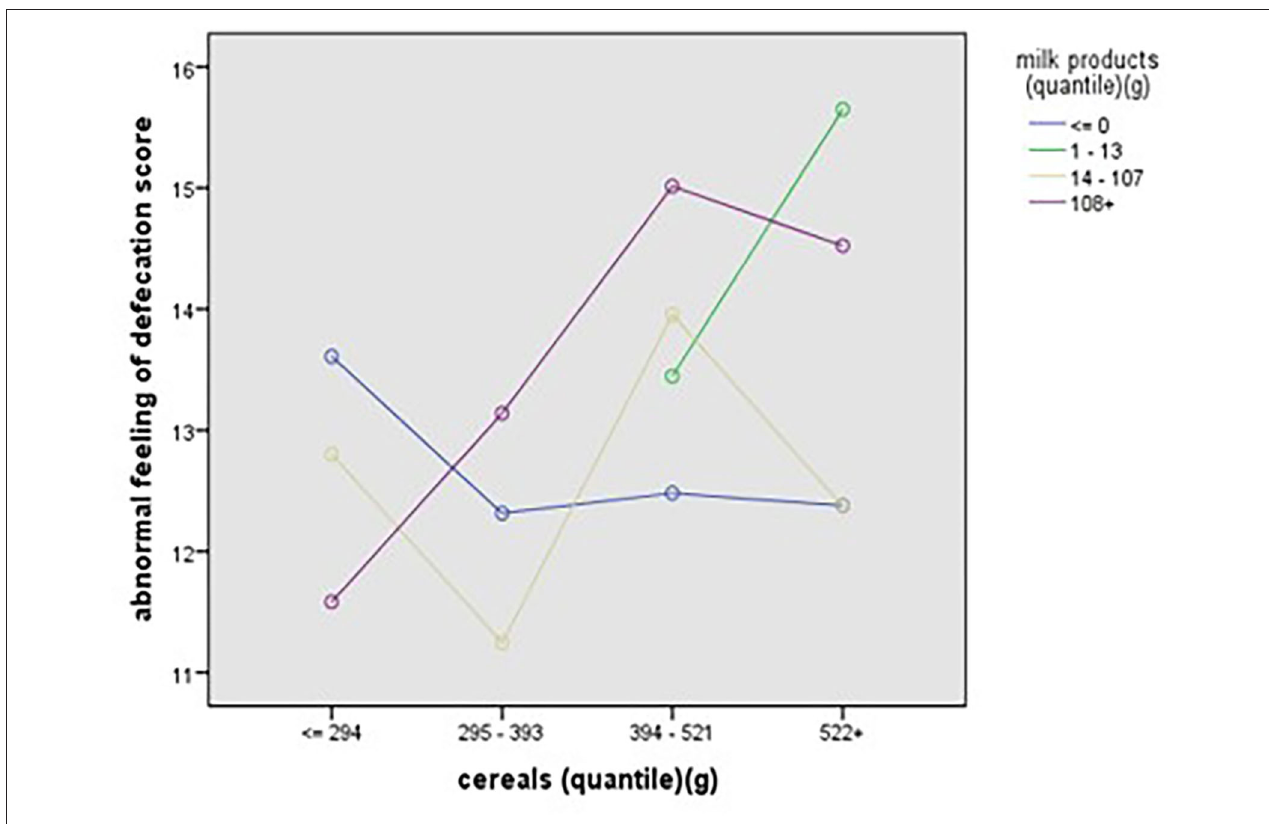
FIGURE 7 | The association of interaction between cereals and milk products with abnormal feeling of